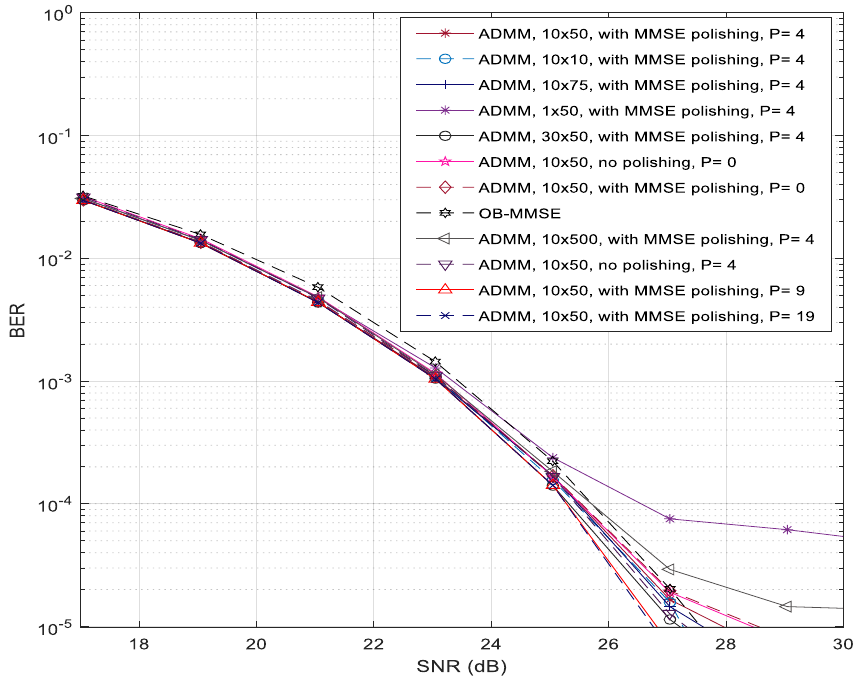
Figure 3. Bit error rate (BER) performance of ADMM in a MU-MIMO scenario with N tx = 255, N rx = 10, N u = 15, N s = 17 and N a = 2, 256-QAM.